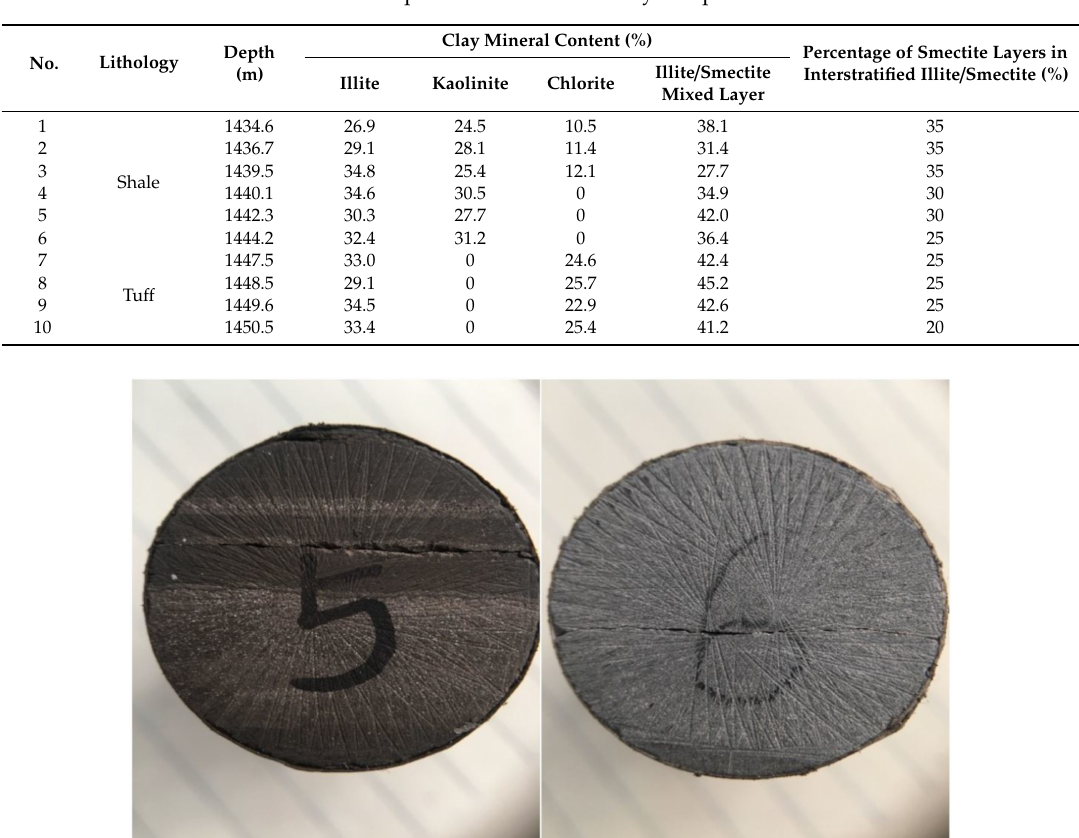
Table 1. Experimental results of clay composition.